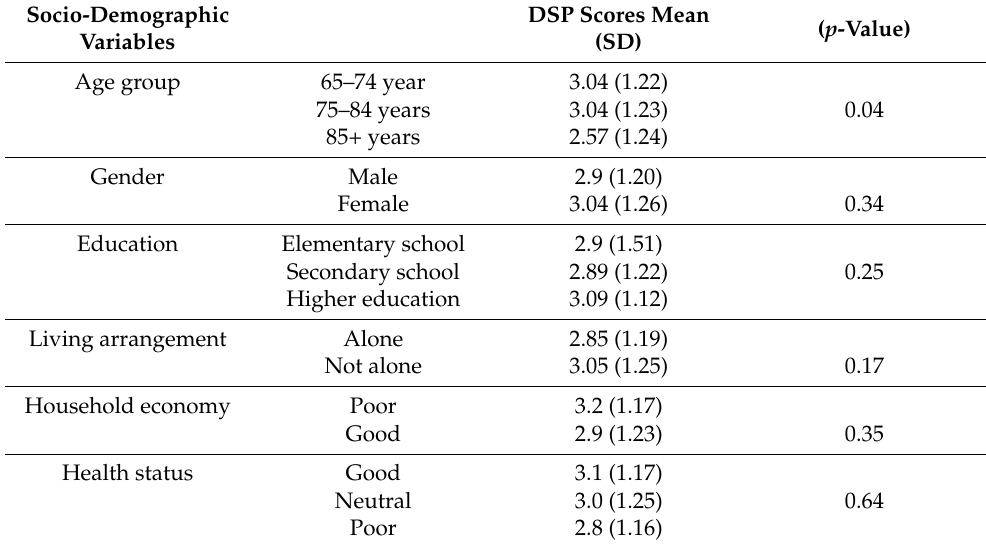
Table 3. Digital social participation score among the socio-demographic variables in a study sample of n = 394 and p -value from Mann-Whitney test/Kruskal Wallis test.